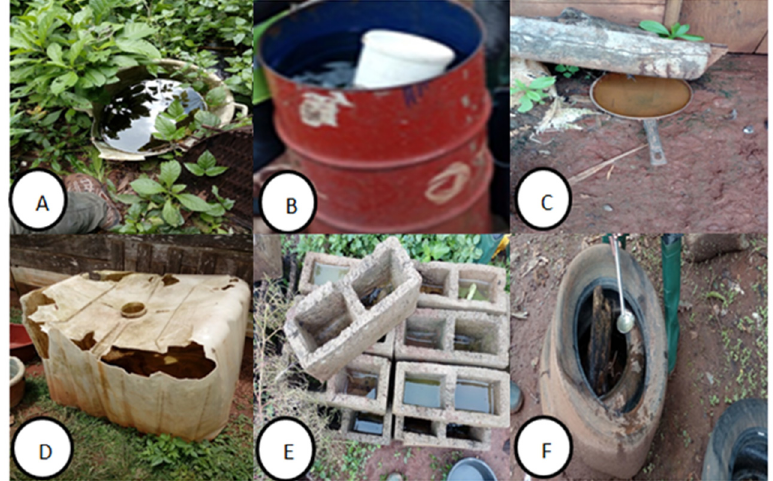
Figure 3. Aedes mosquito breeding habitats ( A ): plastic container; ( B ): tank; ( C ): metal; ( D ): plastic